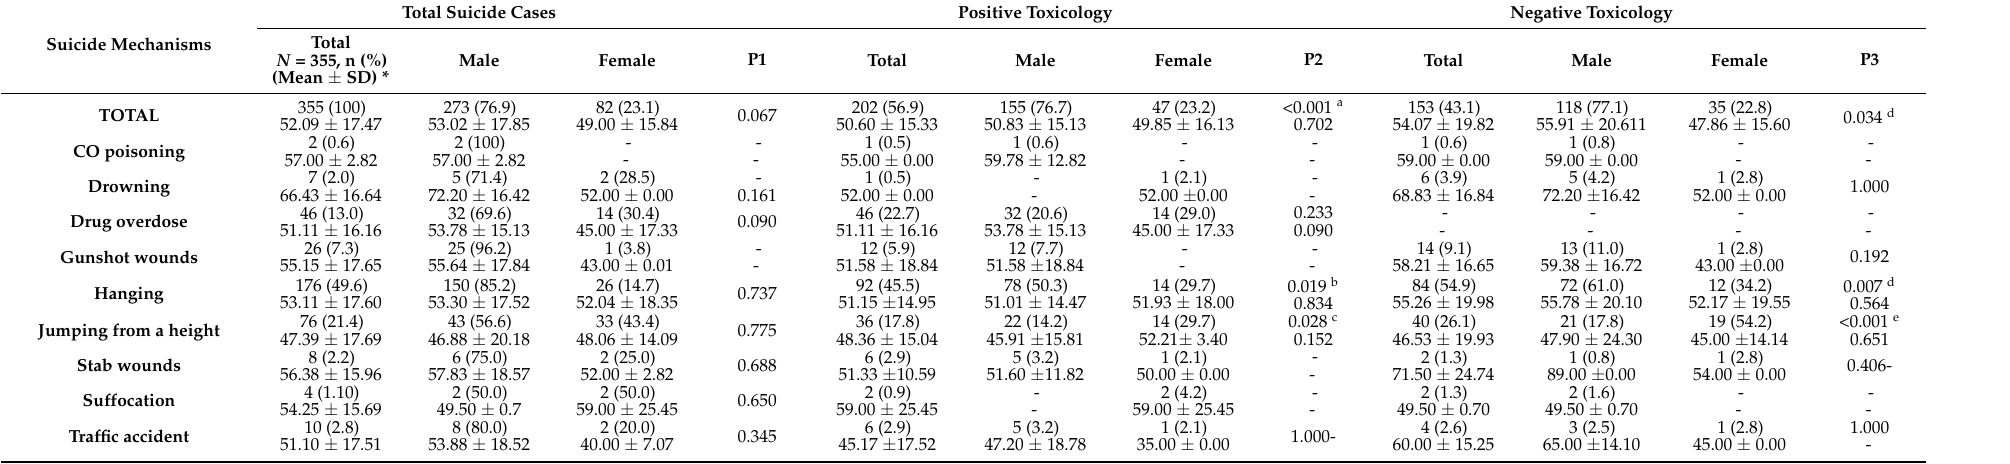
Table 1. Analysis of the frequency of suicides according to suicide mechanism, toxicological findings, and